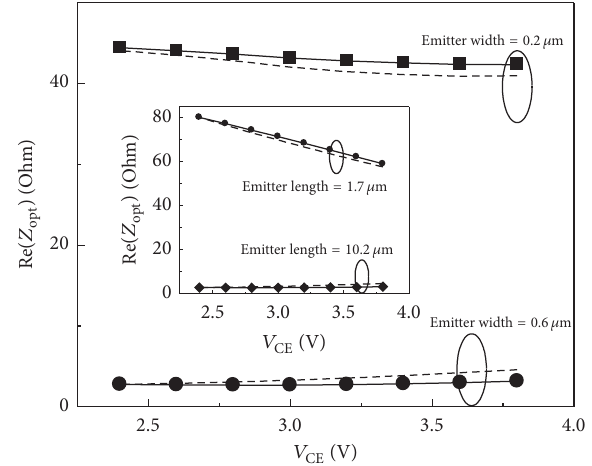
Figure 3: Measured (symbols) and simulated (lines) real part of optimal source impedance versus 𝑉 CE for different emitter widths. 𝑉 BE isat1.1 V.Theoperatingfrequencyisat2 GHz.Theemitterlength is fixed as 10.2 𝜇 m. Solid and dash lines depict the results obtained from the noise model with and without considering the breakdown network, respectively. In the inset, the results for different emitter lengths as the emitter width is fixed as 0.6 𝜇 m are